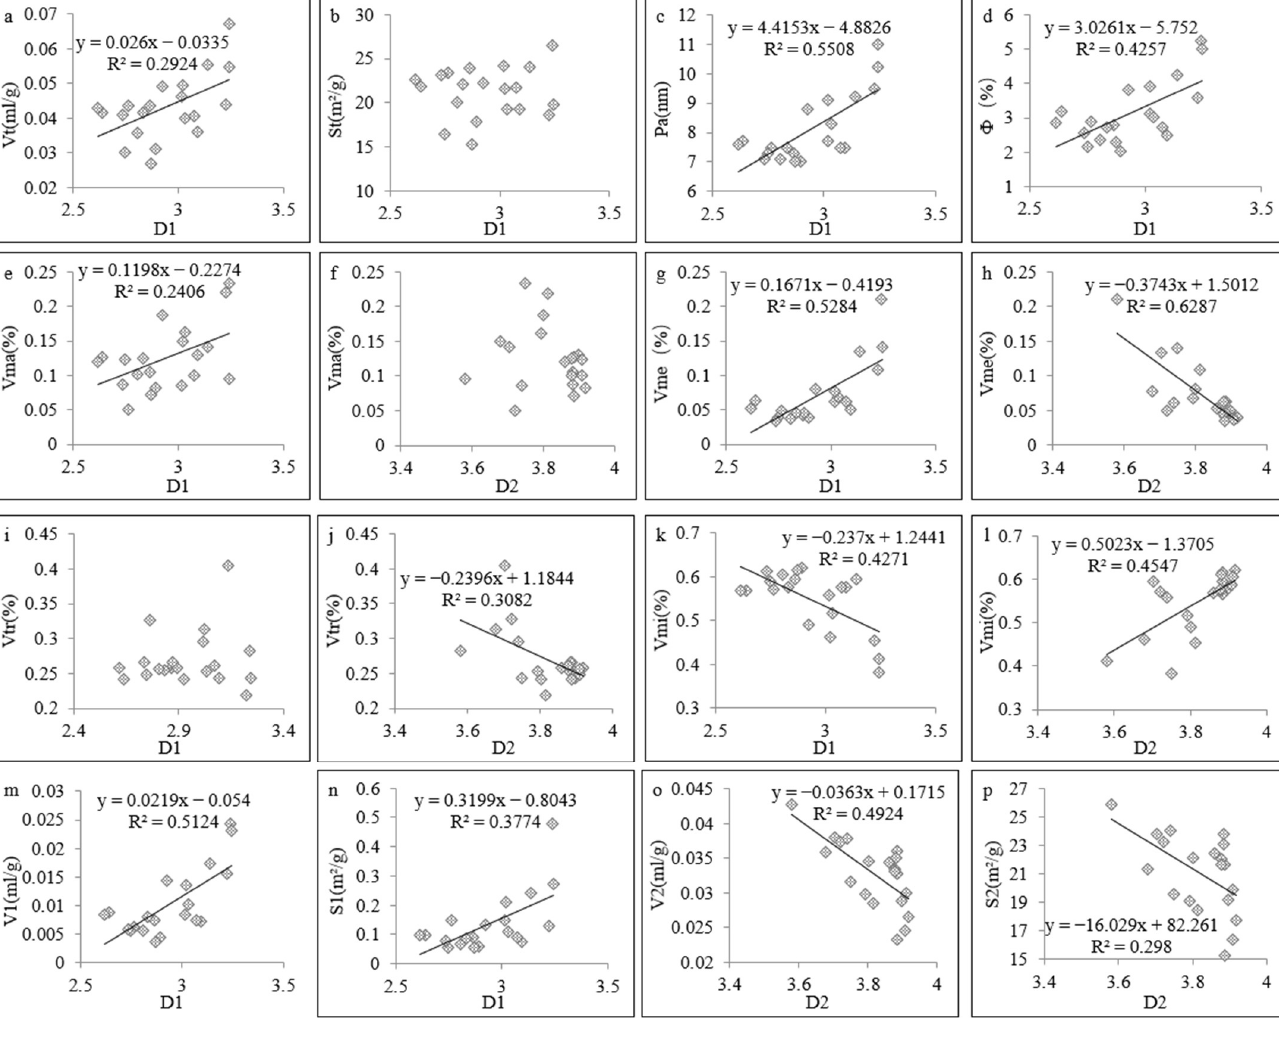
pores with nanoscale pore sizes, the indexes of the pore volume and surface area revealed